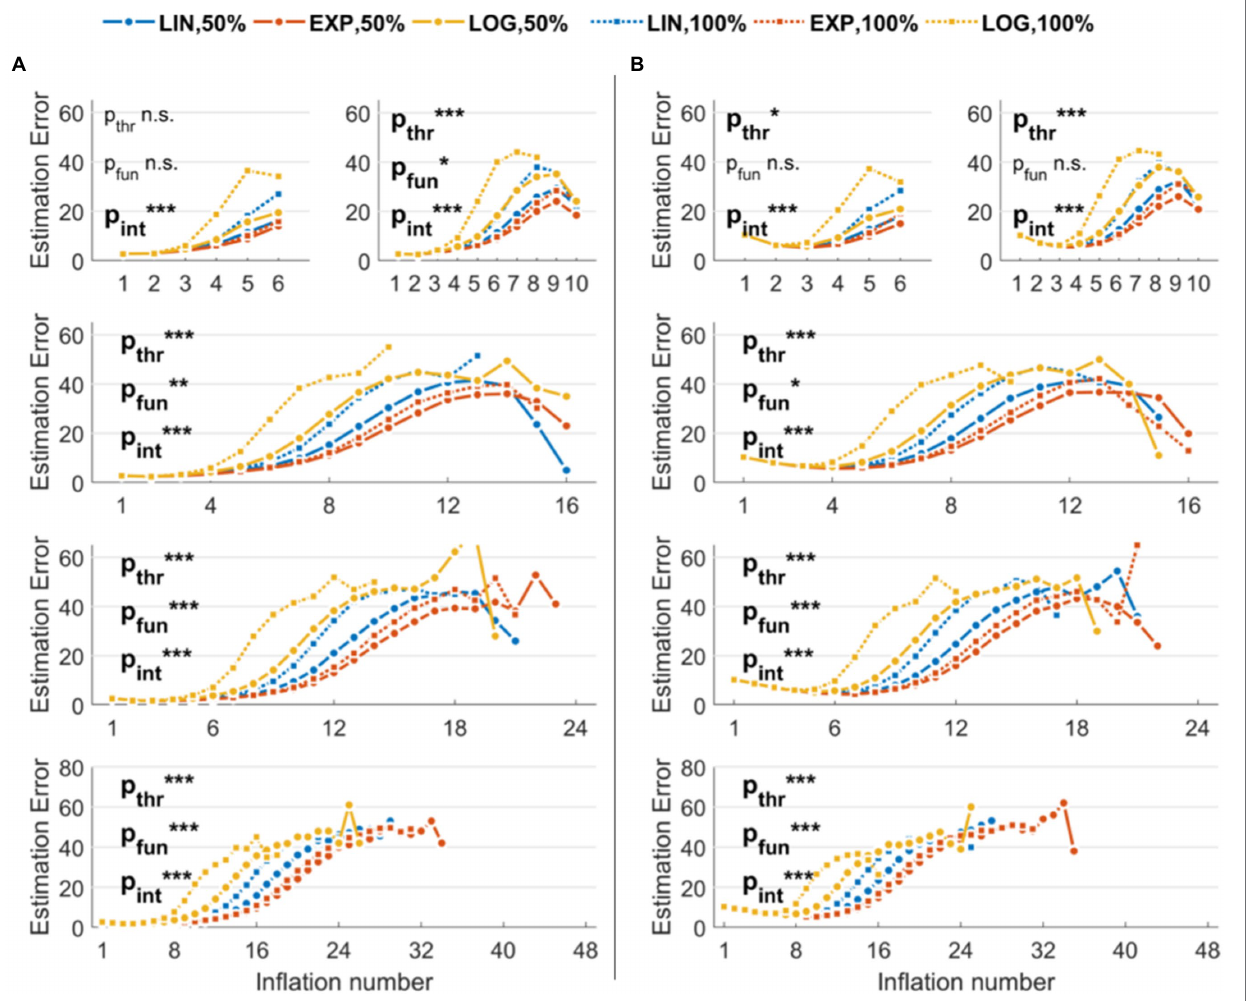
FIGURE 2 | Estimation errors of the stochastic version of the Balloon Analog Risk Task (BART) implemented in the simulations. The three functions used to model explosion probabilities in consecutive inflations are coded by colors (linear, exponential, and logarithmic). The three thresholds indicating maximum explosion probabilities are coded by the marker and line type (only 50 and 100% thresholds are shown to improve readability). (A) Results with low noise levels in the virtual participants’ decisions. (B) Results with high noise levels in the virtual participants’ decisions. Legend: *** p < 0.001; ** p < 0.01; * p <